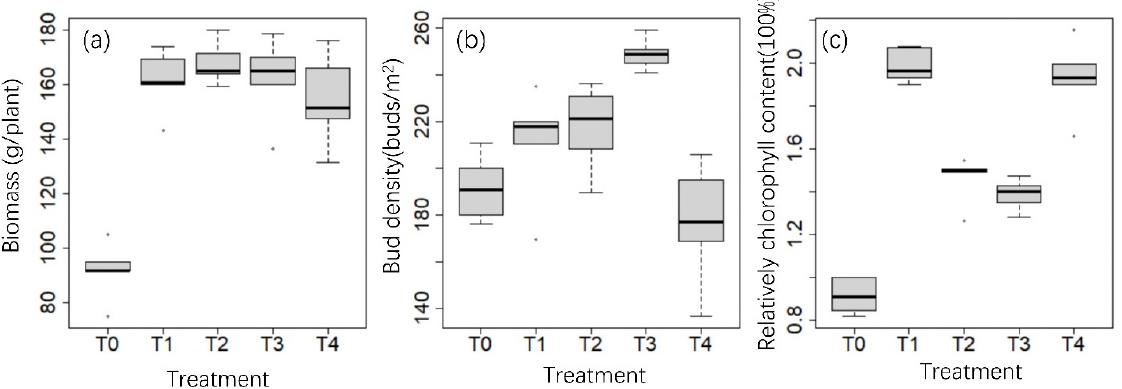
Figure 1. Changes in biomass ( a ), bud density ( b ), and relative chlorophyll content ( c ) in tea plants under different fertilization treatments.